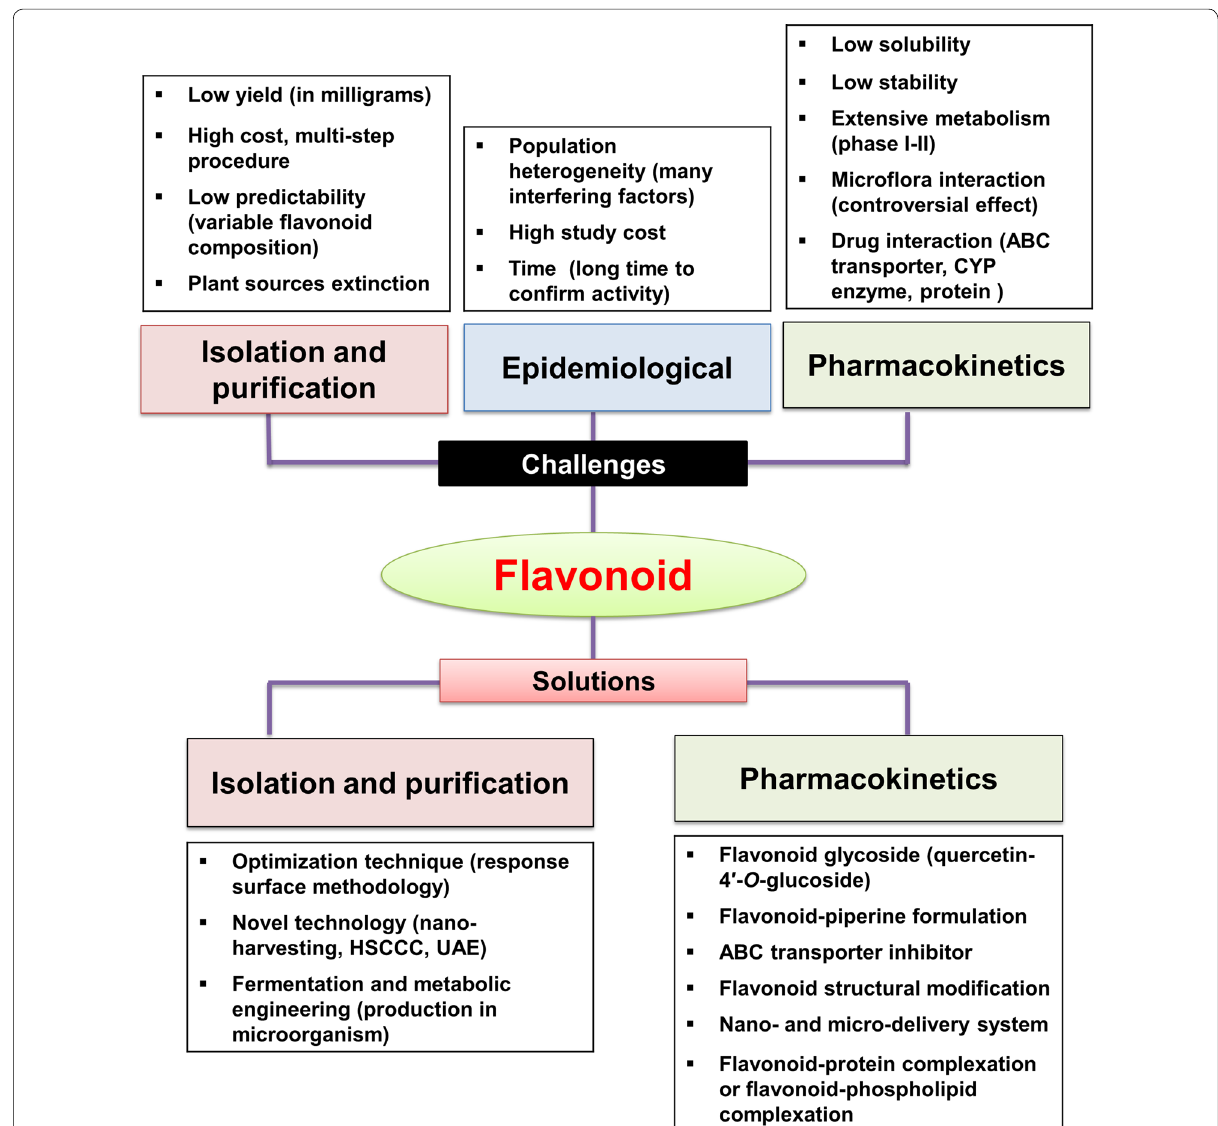
Fig. 2 Challenges associated with flavonoid development and possible approaches to overcome their use as chemopreventive agents. ABC : ATP- binding cassette transporters, CYP : cytochrome P450. HSCCC : high-speed counter-current chromatography, UAE : ultrasound-assisted